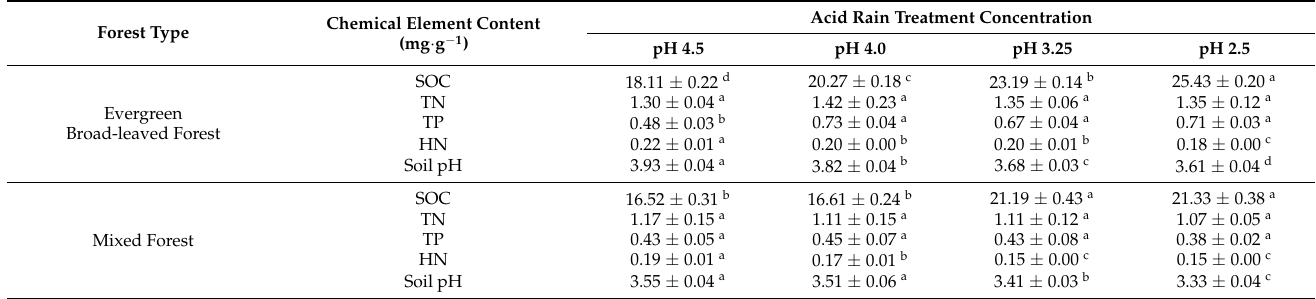
Table 2. Soil chemical properties under different acid rain treatments in April.